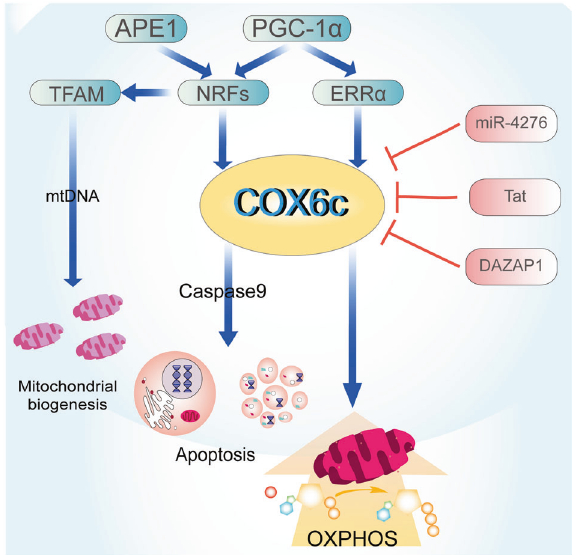
Fig. 1 COX6c regulation and function. COX6c is regulated by multiple factors. (1) On the one hand, APE1 promotes the binding of NRFs to TFAM and regulates mitochondrial biogenesis. In addition, the expression of COX6c is regulated by the redox-dependent coactivator NRFs of APE1; (2) On the other hand, PGC-1 α binds to NRFs and ERR α , respectively, to promote the expression of COX6c, which in turn promotes apoptosis and oxidative phosphorylation. During the whole process, COX6c is negatively regulated by miR- 4276, Tat,